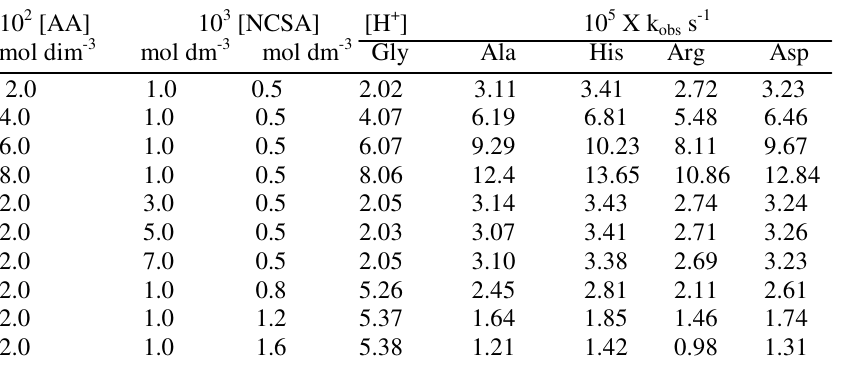
Figure 1. Plots of log [AA] versus log k D=Arginine; E=aspartic acid) Table 1. Effect of varying [amino acid],[NCSA] and [H + ]on the rate of reaction at 30 0 C a